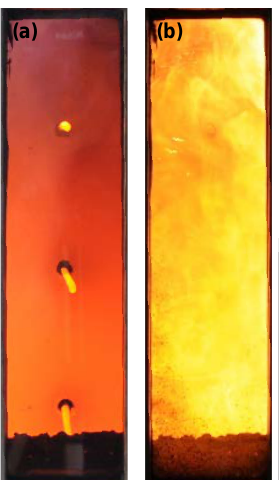
Figure 5. Direct photos of ethanol flame ( a ) and BCO90 flame ( b ) at p = 100 kPa, S = 4.56, Q = 655 LPM. The temperature distribution inside the combustion chamber is represented in a 2D axisymmetric manner by averaging the values at the same radial distance from the axis. The centerline temperatures (thermocouple numbers 1, 8, 15, 22, 29, 37, 45, 52 in Figure 3a) are kept, while the values on the radial distance of 10 cm (thermocouple numbers 2–7, 9–14, etc.) at the specified axial distance are averaged as shown in Figure 3b.